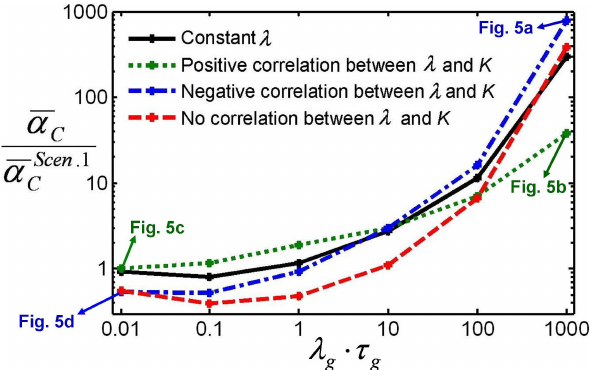
Fig. 4. Total (catchment-average) mass delivery fraction to near- est surface water from all upstream input locations in the Forsmark catchment, ¯ α C . Mass delivery ¯ α C results are shown for different assumptions regarding the correlation between K and λ in the K variability scenario 2, relative to ¯ α C for the K variability scenario 1 (in which both K and λ are constant). Corresponding maps of local mass delivery α to nearest surface water are shown in Fig. 5 for the four specific result points indicated in this